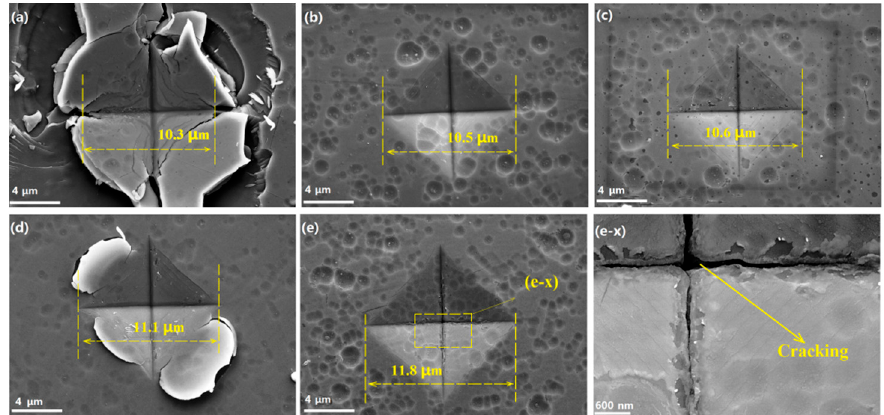
Figure 7. The surface morphology of the indentation generated by Vickers indenter with the load of 100 g. ( a ) #S1 (Ti-0 nm), ( b ) #M2 (Ti-25 nm), ( c ) #M3 (Ti-50 nm), ( d ) #M4 (Ti-100 nm), ( e ) #M5 (Ti-150 nm), ( e-x ) partial enlarged image of ( e ).